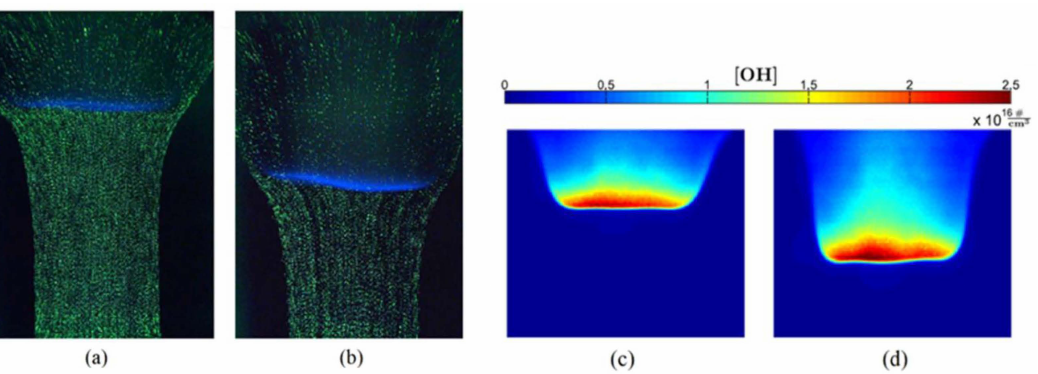
Figure 10. Comparison of PIV images between: ( a ) without the microwave and ( b ) with microwave- assisted plasma ignition at ∅ :0.78 (CH_4); the OH-number density between: ( c ) without the mi- crowave and ( d ) with microwave-assisted plasma ignition at ∅ :0.76 (CH_4)